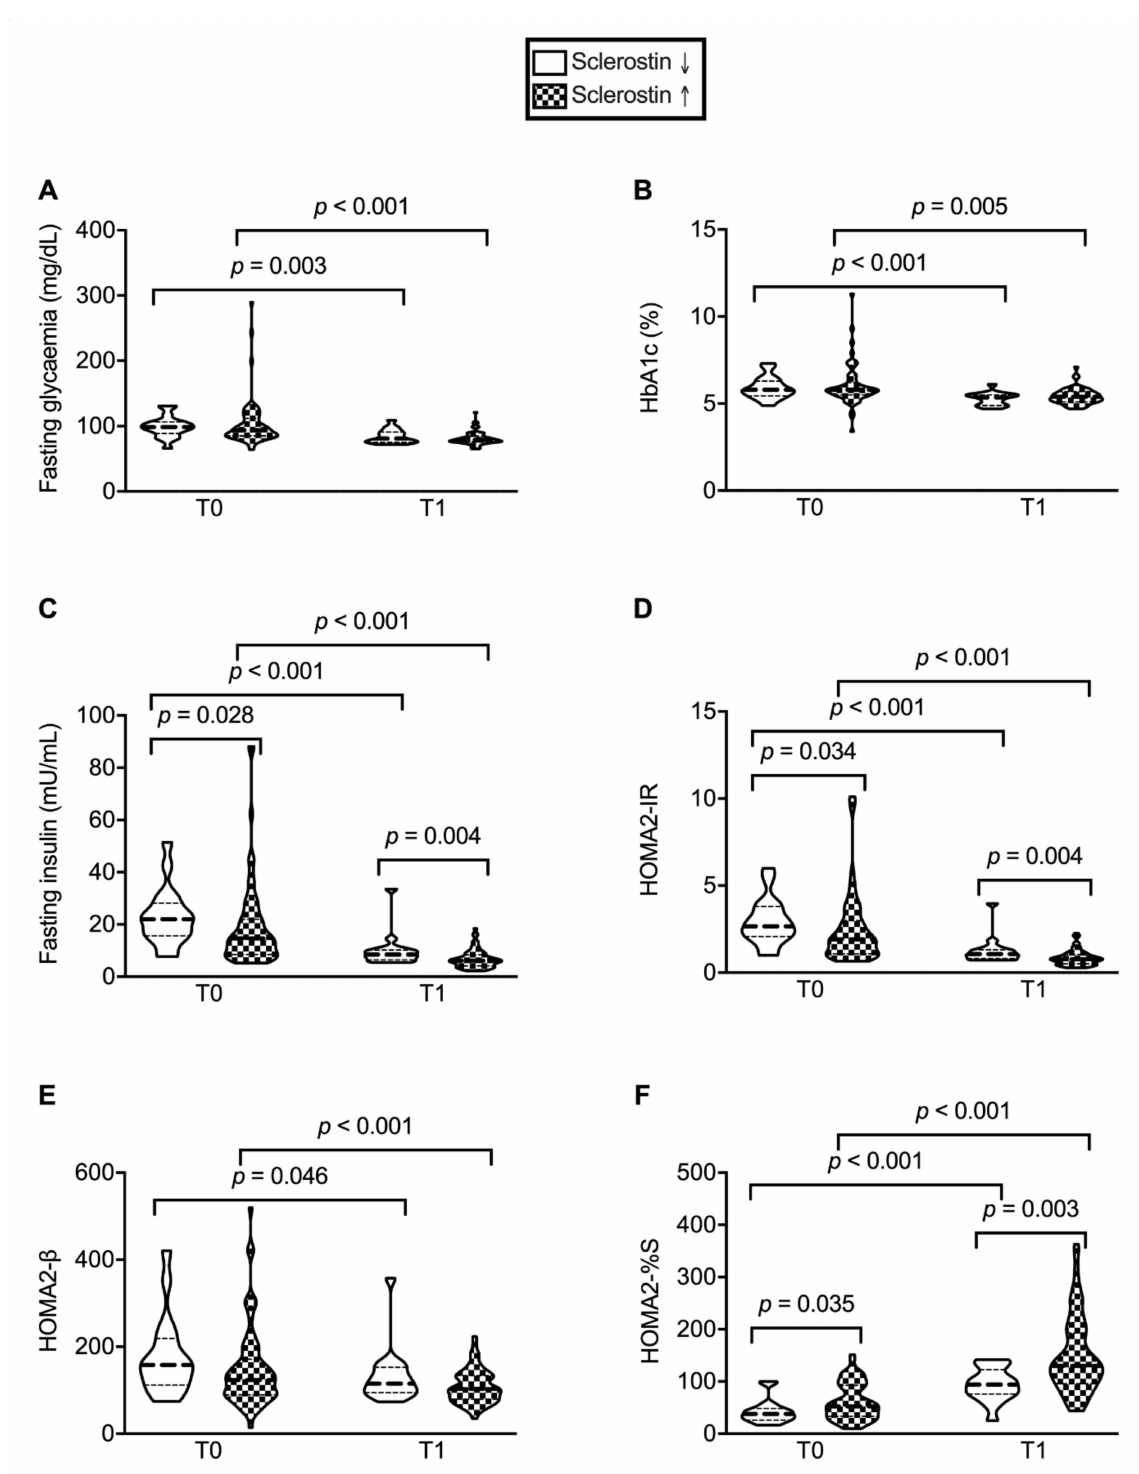
Figure 3. Different glycemic response according to post-surgical changes (decrease vs. increase) in sclerostin levels. Although all patients experienced an improvement in glycemic profile assessed by fasting glycemia ( A ) and glycated hemoglobin (HbA1c) ( B ), higher baseline sclerostin levels—but not post-surgical modification—are associated with higher insulin ( C ), homeostatic model assessment (HOMA)2 for insulin resistance (IR) ( D ), β cell function ( β ) ( E ) and peripheral insulin sensitivity (S) IR ( F